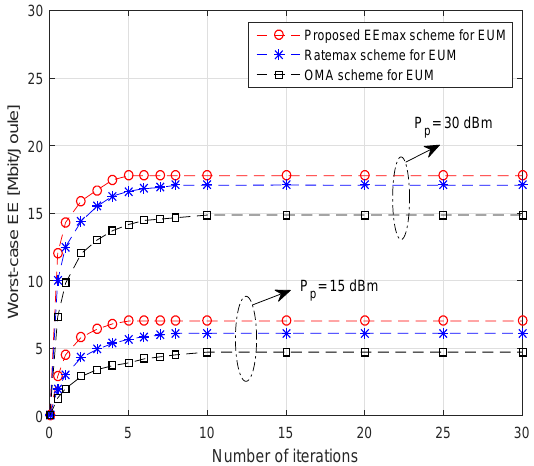
Figure 3. Worst-case EE versus number of iterations.